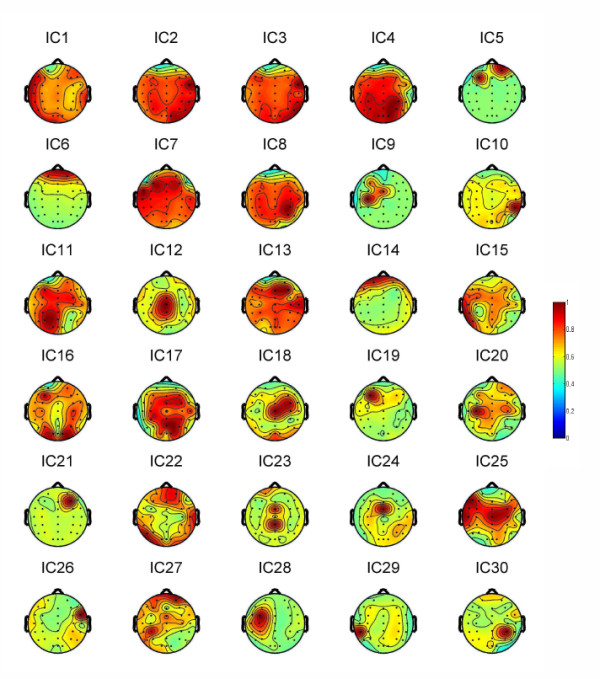
Regularized Scalp maps of all the independent components (ICs). This figure shows the scalp maps of all the ICs based on the data of Subject 3.